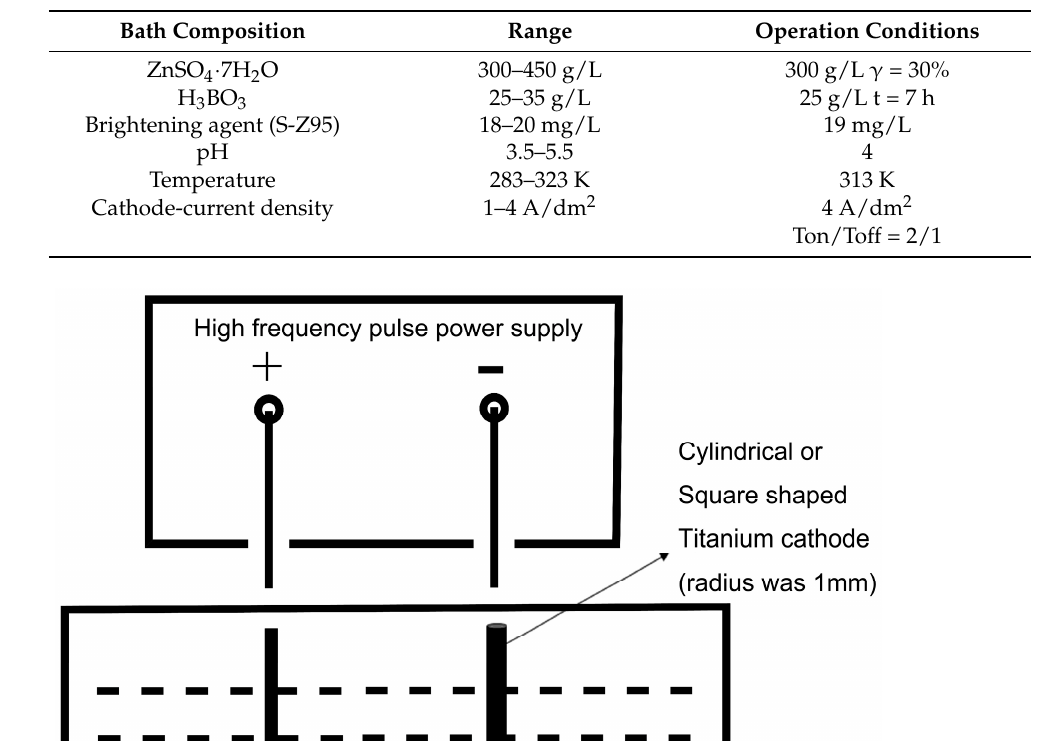
Table 1. The composition of the electro-deposition solution and operation conditions. Table 1. The schematic diagram of the experiment device.